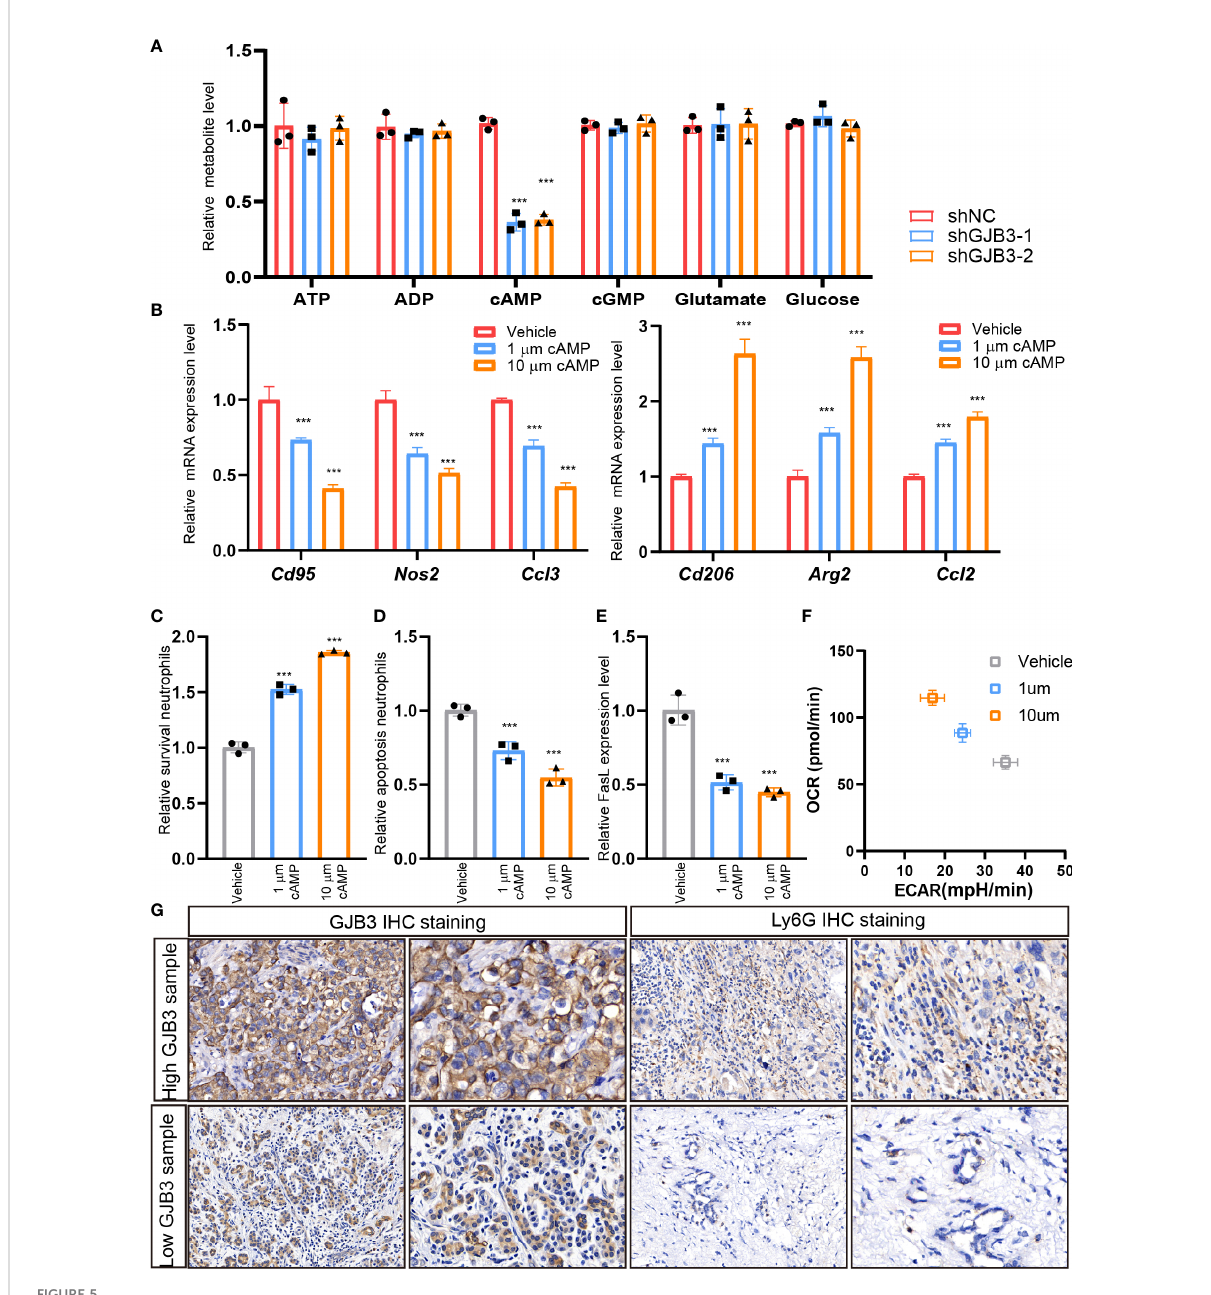
FIGURE 5 GJB3 transfer cAMP to regulating neutrophil polarization and survival (A) . The quanti fi cation of metabolites in the culture supernatant from shNC, shGJB3-1 and shGJB3-2 KPC1199 cells. (B) . The relative Cd95 , Nos2 , Ccl3 , Cd206, Arg2 and Ccl2 mRNA expression under KPC cells treated with 1 m m cAMP, 10 m m cAMP. (C, D) . The survival and apoptosis neutrophil upon treated with different dose of cAMP. (G) . The IHC staining of GJB3 and Ly6G in human liver metastasis specimens. Scale bar is 50 m m. Data presented as mean±standard deviation.